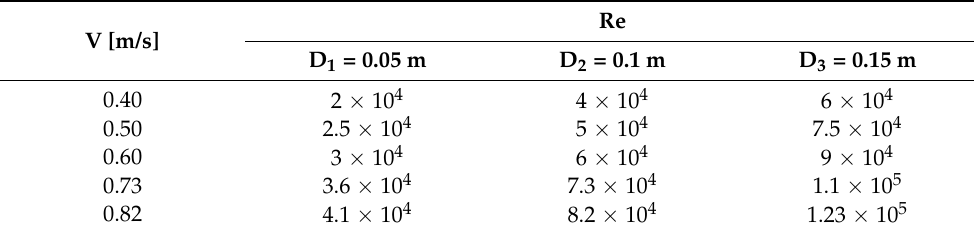
Table 3. Reynolds numbers for all analyzed water flow conditions and cylinder diameter cases used in the wave flume experiments and numerical simulation.